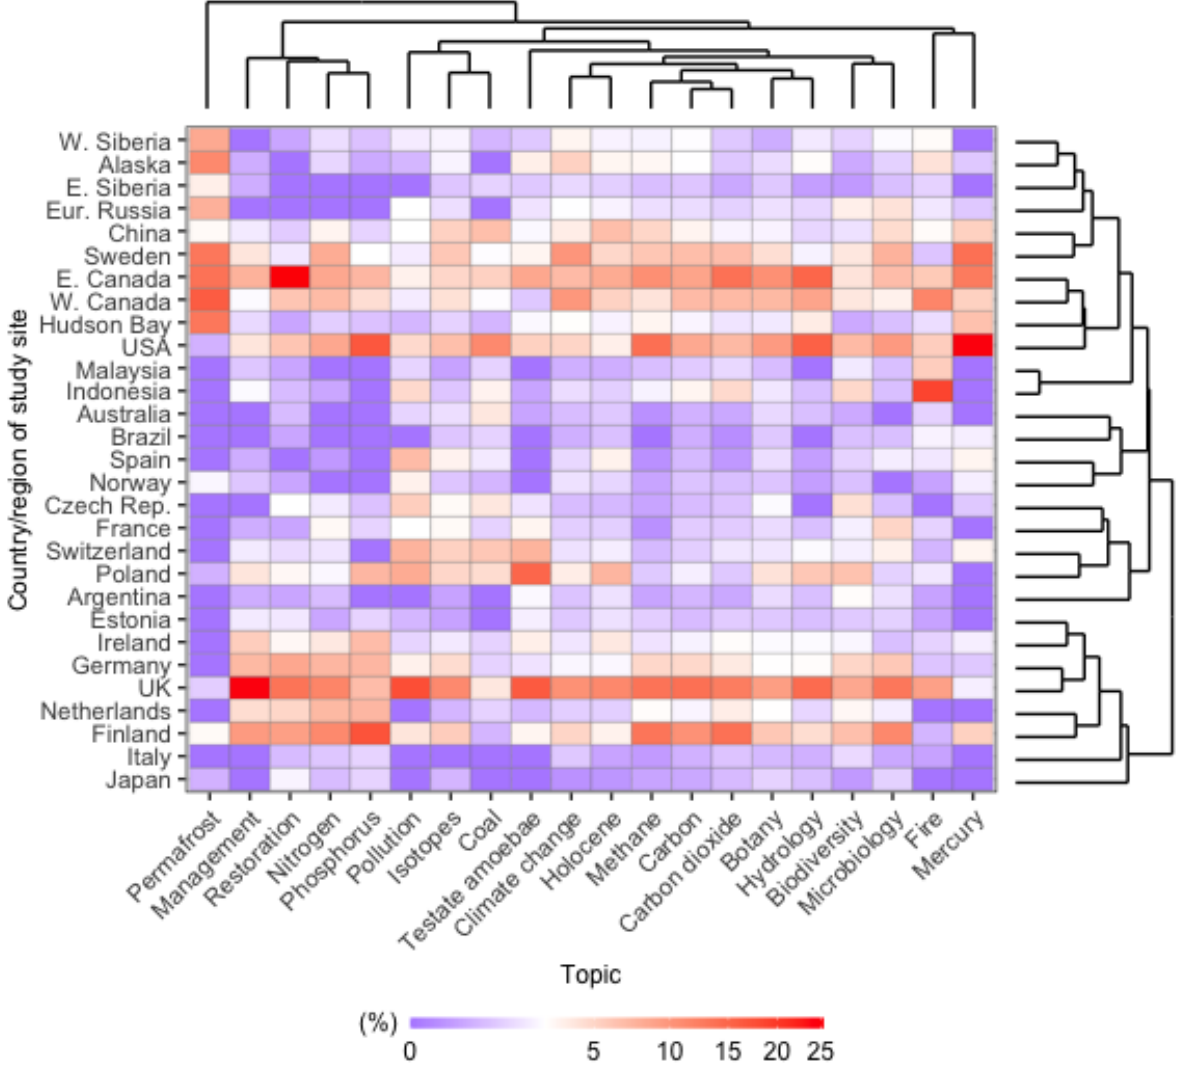
Figure 10. Relative number of study sites, indicated by colour (legend at the bottom) at the country/region level, for each topic. Countries/regions and topics are sorted according to hierarchical clustering, following dendrograms at the right and top of the